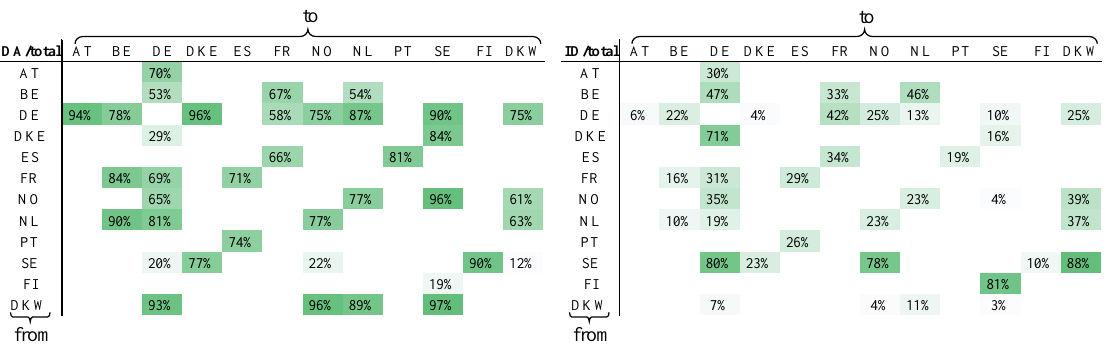
Figure A6. CB trading volumes in relation to the total trading volume for